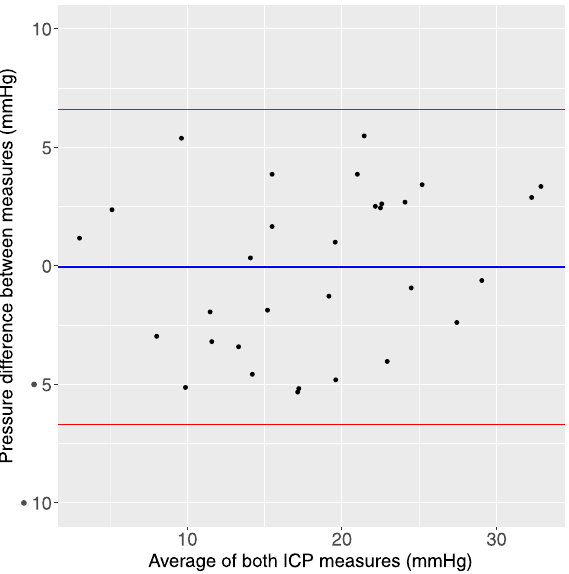
Figure 4. Bland–Altman graph shows the difference between estimated and ‘true’ ICP vs the average of the two pressure estimates. The mean is shown (blue line) as well as ± 1.96 standard deviations (red lines).